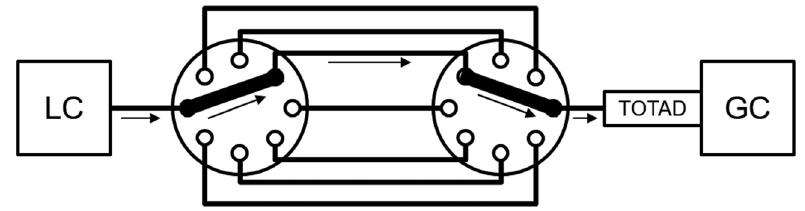
Figure 2: Scheme of the fraction collector used in online LC - GC using the TOTAD interface, when more than one LC fraction is to be